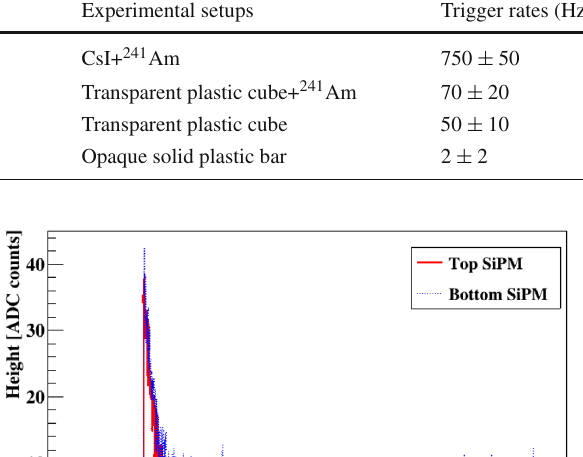
the plastic cube was replaced by an opaque solid plastic bar.